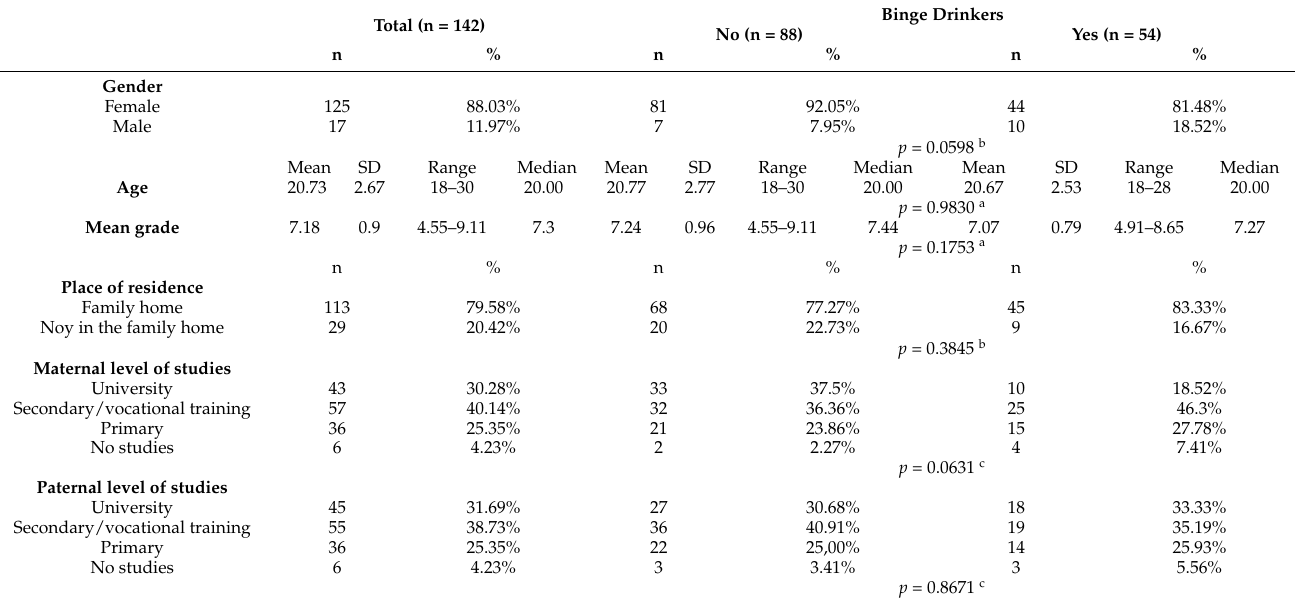
Table 1. Sociodemographic and academic